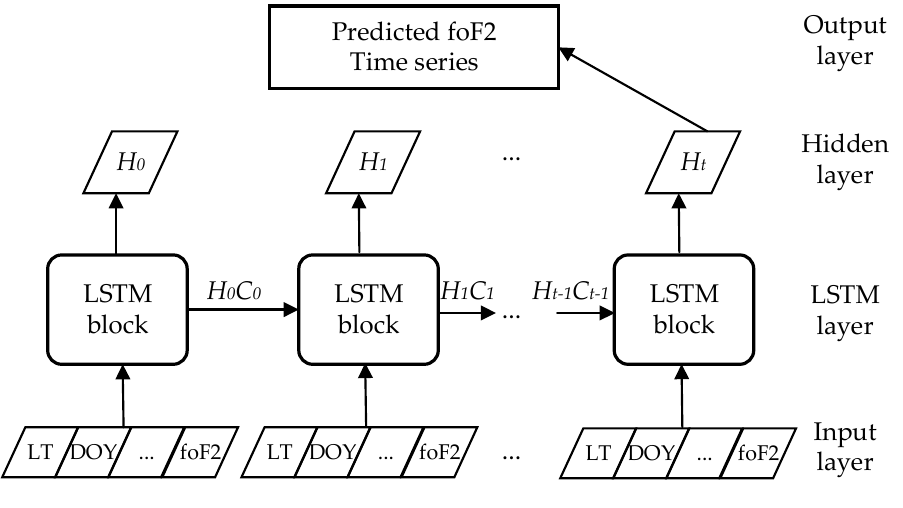
Figure 3. A block diagram of the LSTM